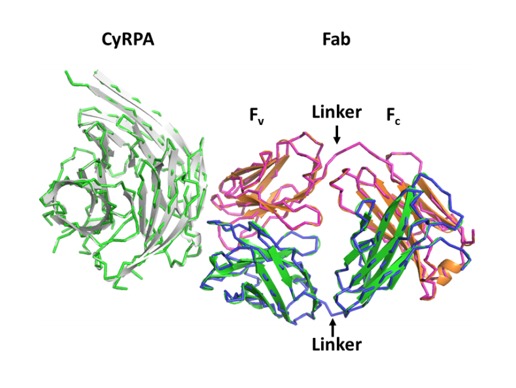
DOI:
http://dx.doi.org/10.7554/eLife.20383.021